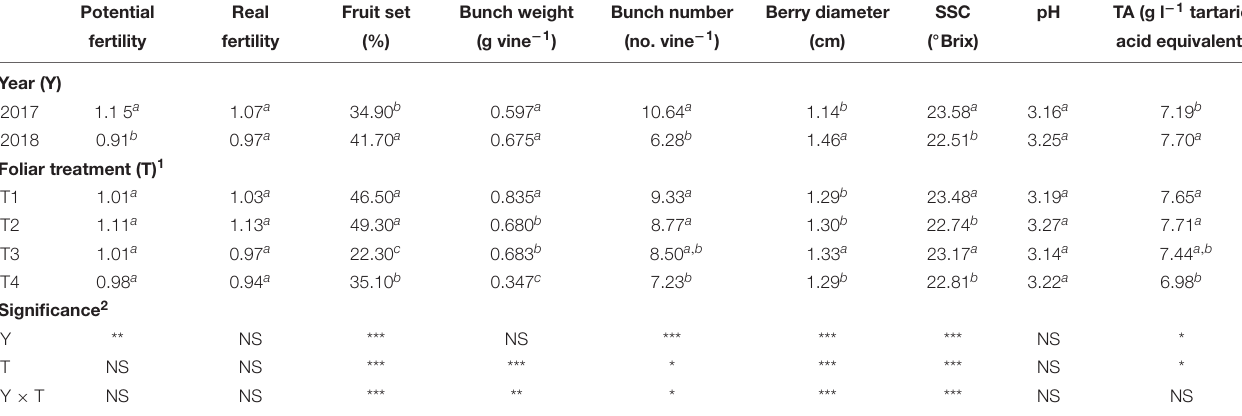
TABLE 2 | Main effects of year and foliar treatment on potential and real fertility of shoots, fruit set, bunch weight and number, berry diameter, berry juice soluble solids content (SSC), pH, and titratable acidity (TA) of V. vinifera “Aglianico” vines. Mean values and significance of main factors’ interactions are shown. Different letters within column indicate significant differences according to Duncan’s multiple-range test ( P ≤